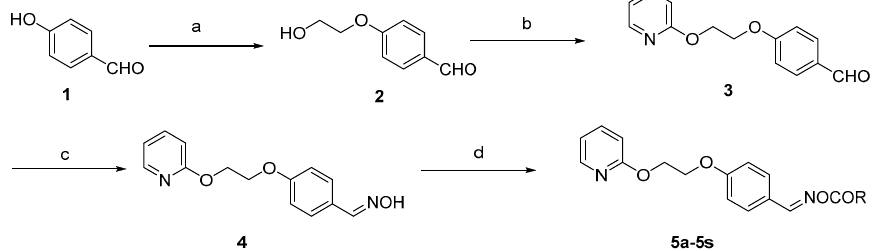
Scheme 1. General synthetic route for target compounds. Reagents and conditions: (a) BrCH 2 CH 2 OH,